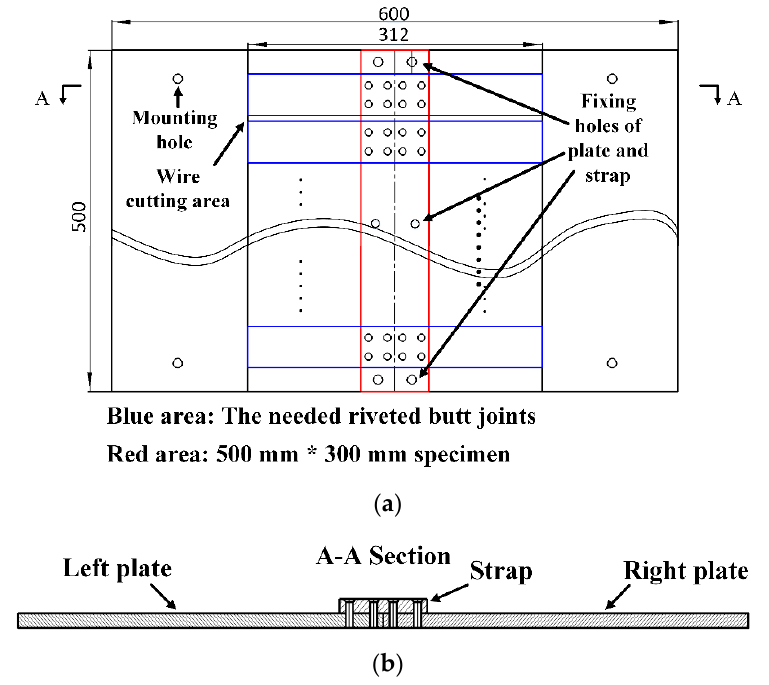
Figure 17. The double-riveted single strap joint specimen. ( a ) Top view and ( b ) side view.